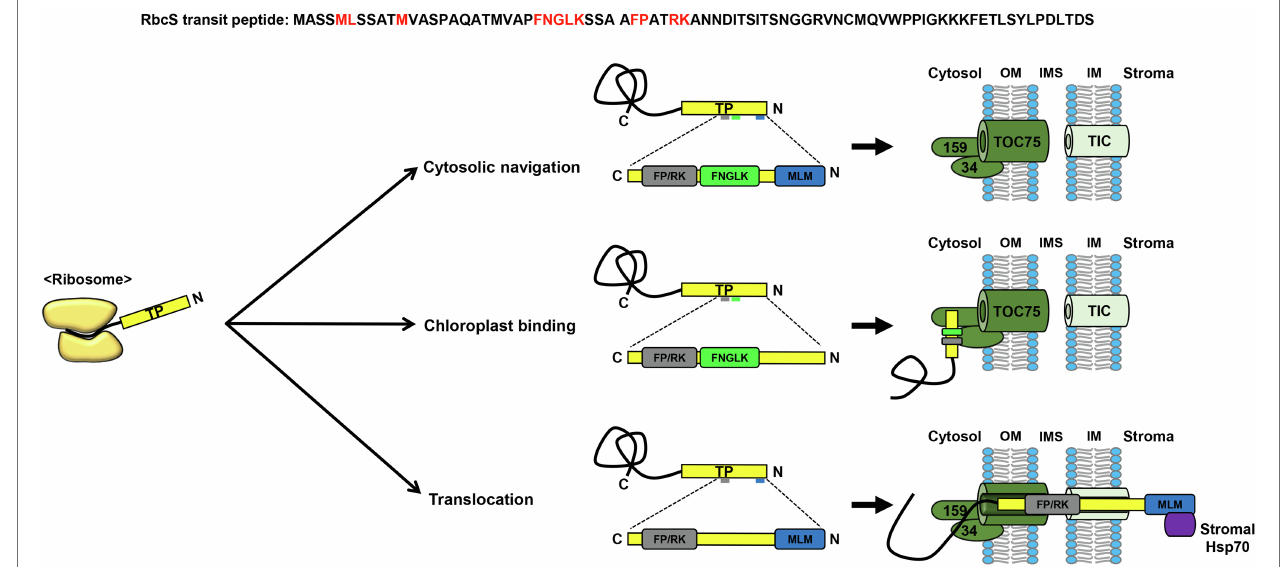
FIGURE 1 | Sequence motifs in the Rubisco small subunit transit peptide. Among the sequence motifs in the Rubisco small subunit (RbcS) transit peptide, the motifs, MLM, FNGLK, and FP/RK have been extensively characterized. The MLM motif is vital not only for cytosolic navigation, but also for translocation across chloroplast membranes, by interacting with stromal Hsp70. The FNGLK and FP/RK motifs have been demonstrated to mediate chloroplast binding via interactions with Toc34. The segment containing the FP/RK motif lies in close proximity to the TOC/TIC translocons during preprotein translocation, which may be essential for the efficient translocation of RbcS. TP, transit peptide; OM, outer membrane; IMS, intermembrane space; IM, inner